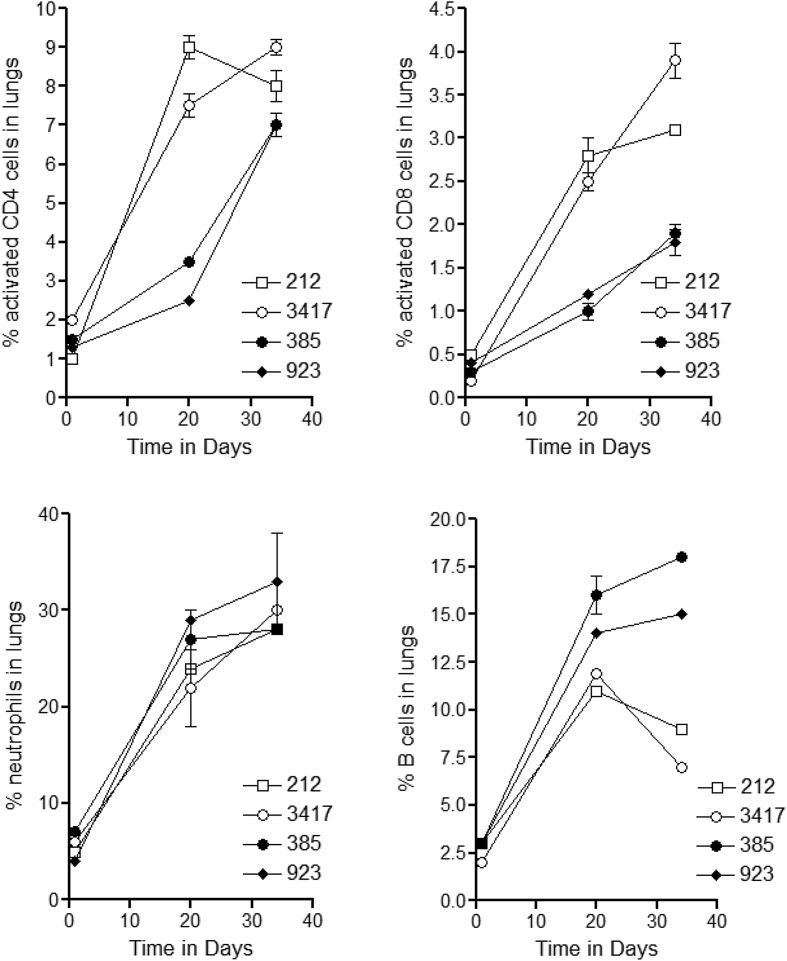
Flow cytometric analysis of the leukocyte response in the lungs during the course of infection with very high transmission strains [212, 3417] or unique strains [385, 923]. Data shown as the mean of 5 measurements ±SEM.